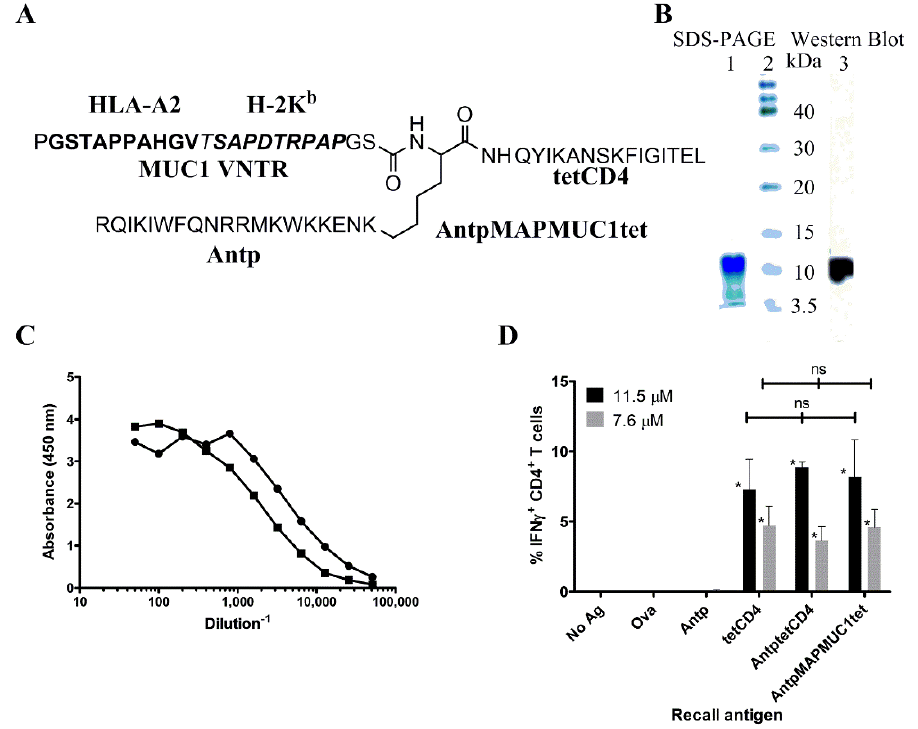
Figure 1. ( A ) Structure of the AntpMAPMUC1tet immunogen. The HLA-A2 restricted CTL epitope and the H2-K b epitope of the mucin 1 (MUC1) variable number of tandem repeat (VNTR) is denoted in bold type. ( B ) SDS-PAGE and western blot analysis of AntpMAPMUC1tet (lane 1), molecular weight markers (lane 2). Anti-MUC1 antibody, 1.3.14 was used for western blot analysis (lane 3). ( C ) Binding of anti-MUC1 antibodies to AntpMAPMUC1. AntpMAPMUC1tet was coated onto a 96-well microtitre plate and bound peptide detected with anti-MUC1 antibody, BC2 recognizing the DTR epitope (●) and 1.3.14 antibody recognizing the APPAH epitope ( ■ ) in the tripartite peptide, AntpMAPMUC1tet. ( D )Tetanus toxoid CD4 T cell epitope (tetCD4) in AntpMAPMUC1tet is processed and presented by human MoDC to tetCD4-specific human T cell lines. MoDC were pulsed with equimolar concentrations (7.6 or 11.5 uM) of tetCD4, AntptetCD4, AntpMAPMUC1tet or Antp, OVA (non-specific control antigens) for 14 hr before the addition of responder cells for 15 h. Golgistop was added for a further 4 h before the cells were stained for CD4 and intracellular IFN γ . MoDC alone with or without OVA or Antp were used as negative controls for non-specific IFN γ production. Values represent IFN production in tetCD4-specific T cells ± SEM stimulated by pulsed MoDC from 3 different donors. * p < 0.05.